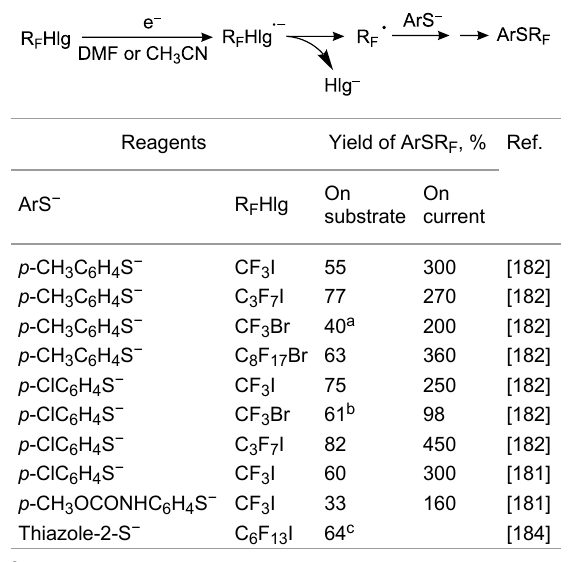
Table 9: Formation of aryl perfluoroalkyl sulfides by electrochemical initiated reactions of ArS − with R F Hlg.